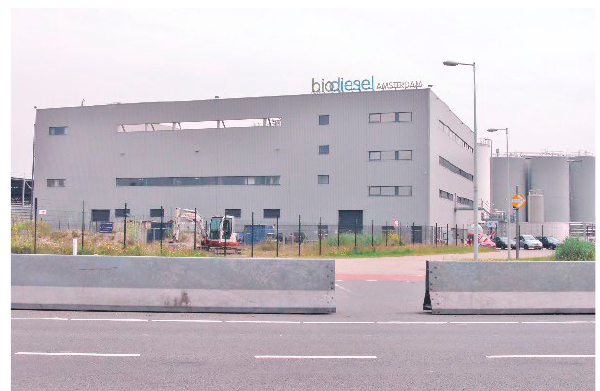
Scheme 2. Schematic representation of Biodiesel production pro- cess from vegetable oil. Figure 1. Biodiesel Production facility at Port